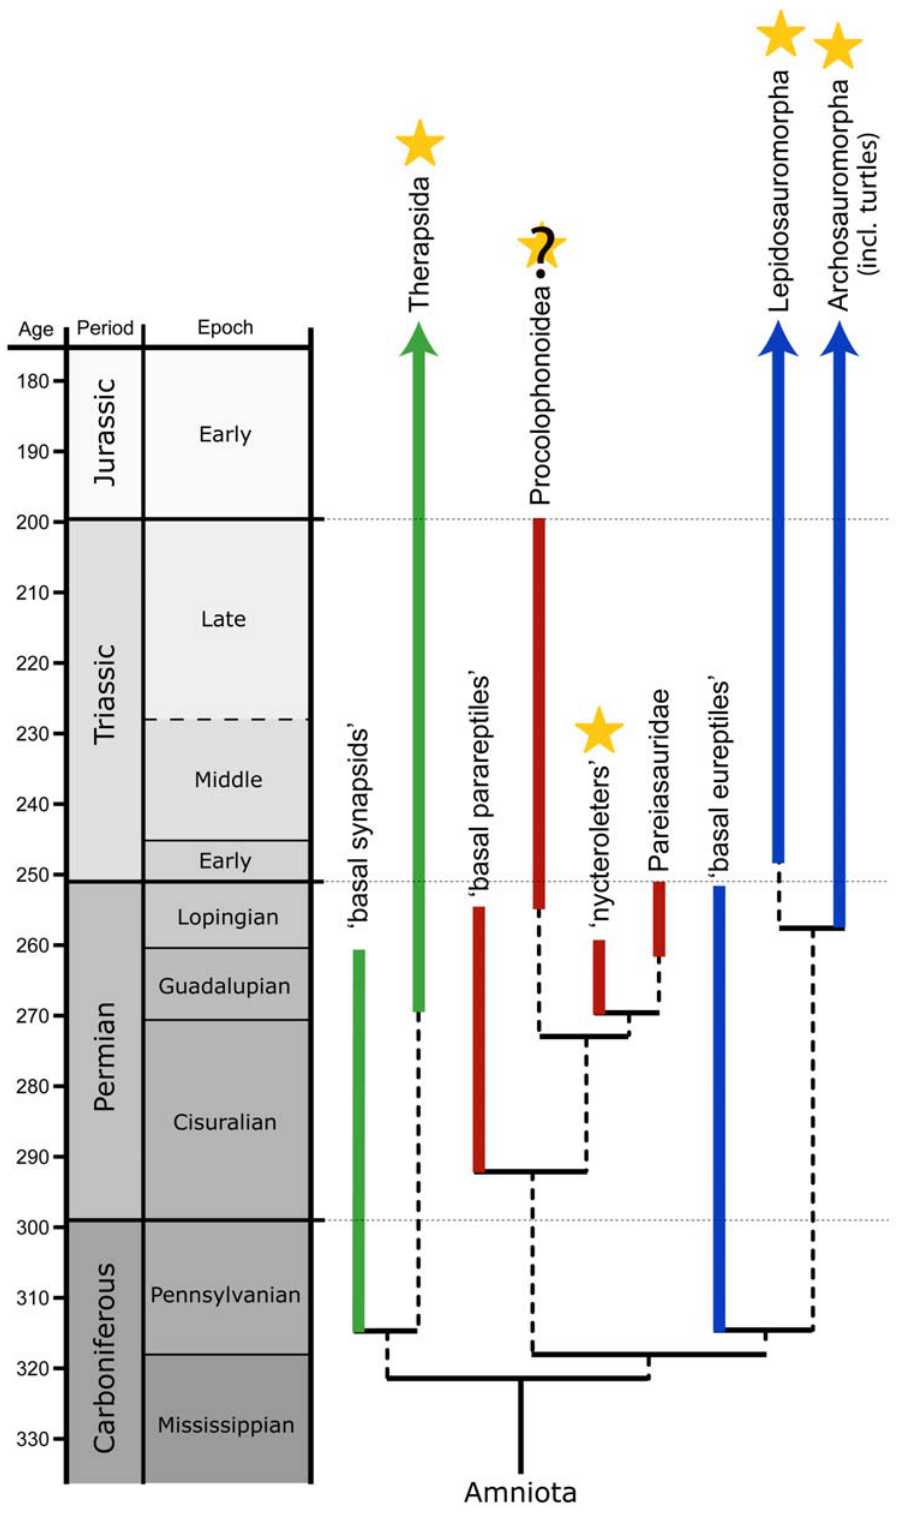
Figure 5. The occurrence of impedance-matching hearing within amniotes. A middle ear exhibiting the functional criteria for impedance-matching has thus far been recorded in synapsids, lepidosauromorphs, and archosauromorphs (marked with an asterisk), and was assumed not to have evolved before the Mesozoic; the presence of a tympanic middle ear in the taxa of our study (here informally named ‘‘nycteroleters’’) represents the only known occurrence of such a structure in Paleozoic amniotes. Whether or not a true tympanic middle ear was also present in a closely related clade, the Procolophonoidea, remains unresolved.